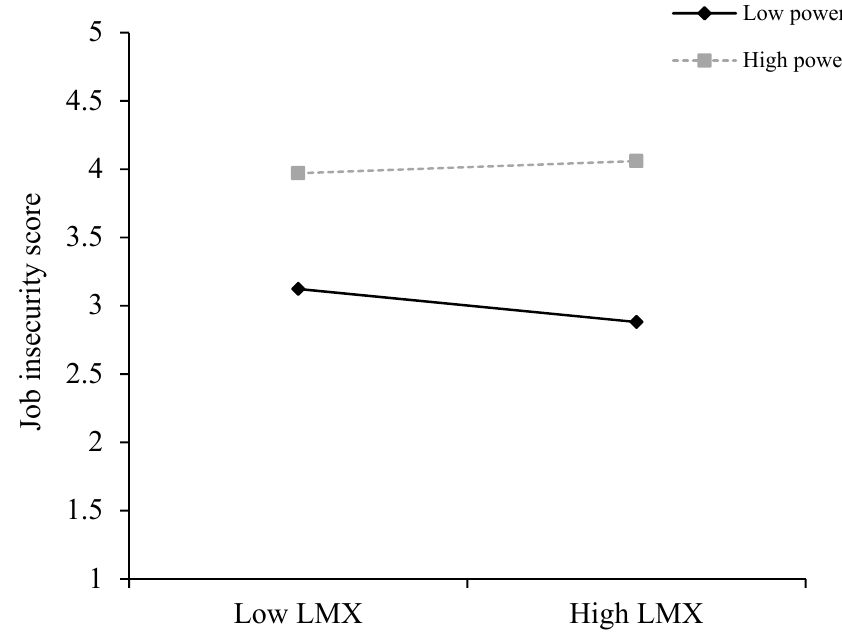
Figure 2. Interaction effect of LMX and power distance on job insecurity.